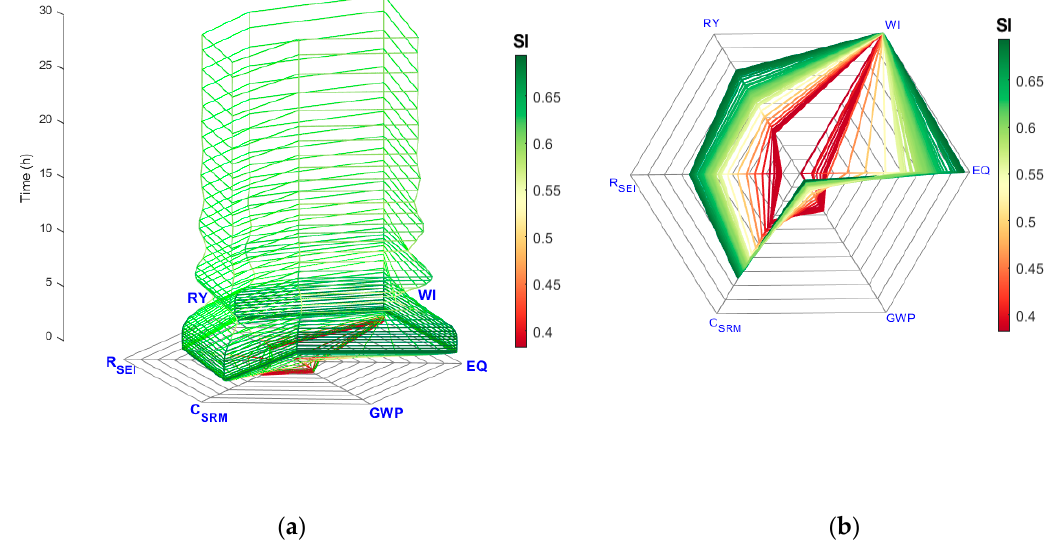
Figure 5. Dynamic sustainability performance of open-loop simulation (red represents less sustainable, while green more sustainable according to calculated SI values): ( a ) 3D sustainability indicator dynamic radar plot; ( b ) 2D projection of sustainability indicator radar plot.